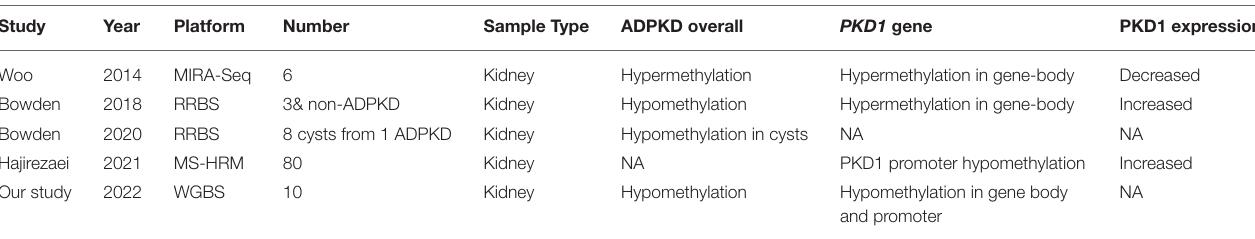
TABLE 1 | Summary of DNA methylation analysis in